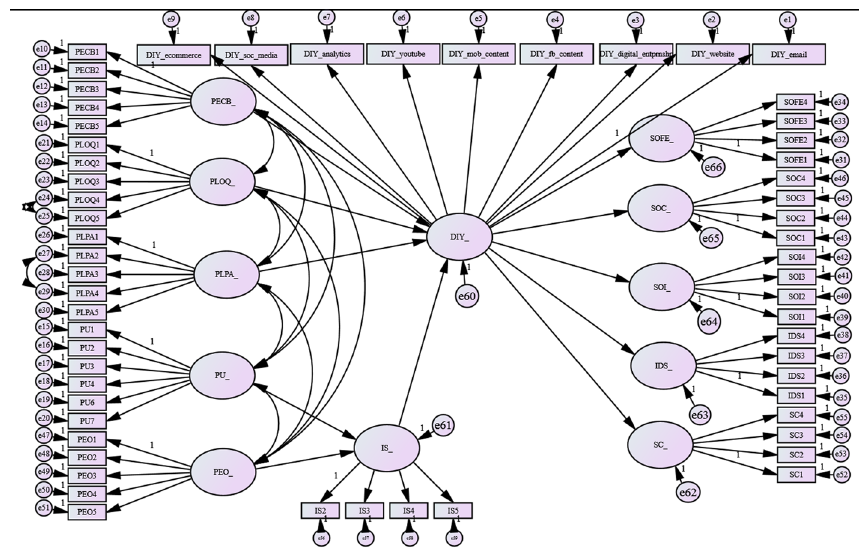
Fig. 3 Structural model